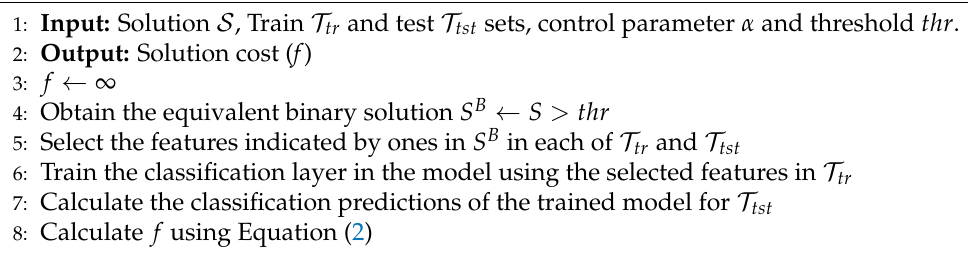
Algorithm 1 Cost Function ( S , T tr , T tst , α , thr )